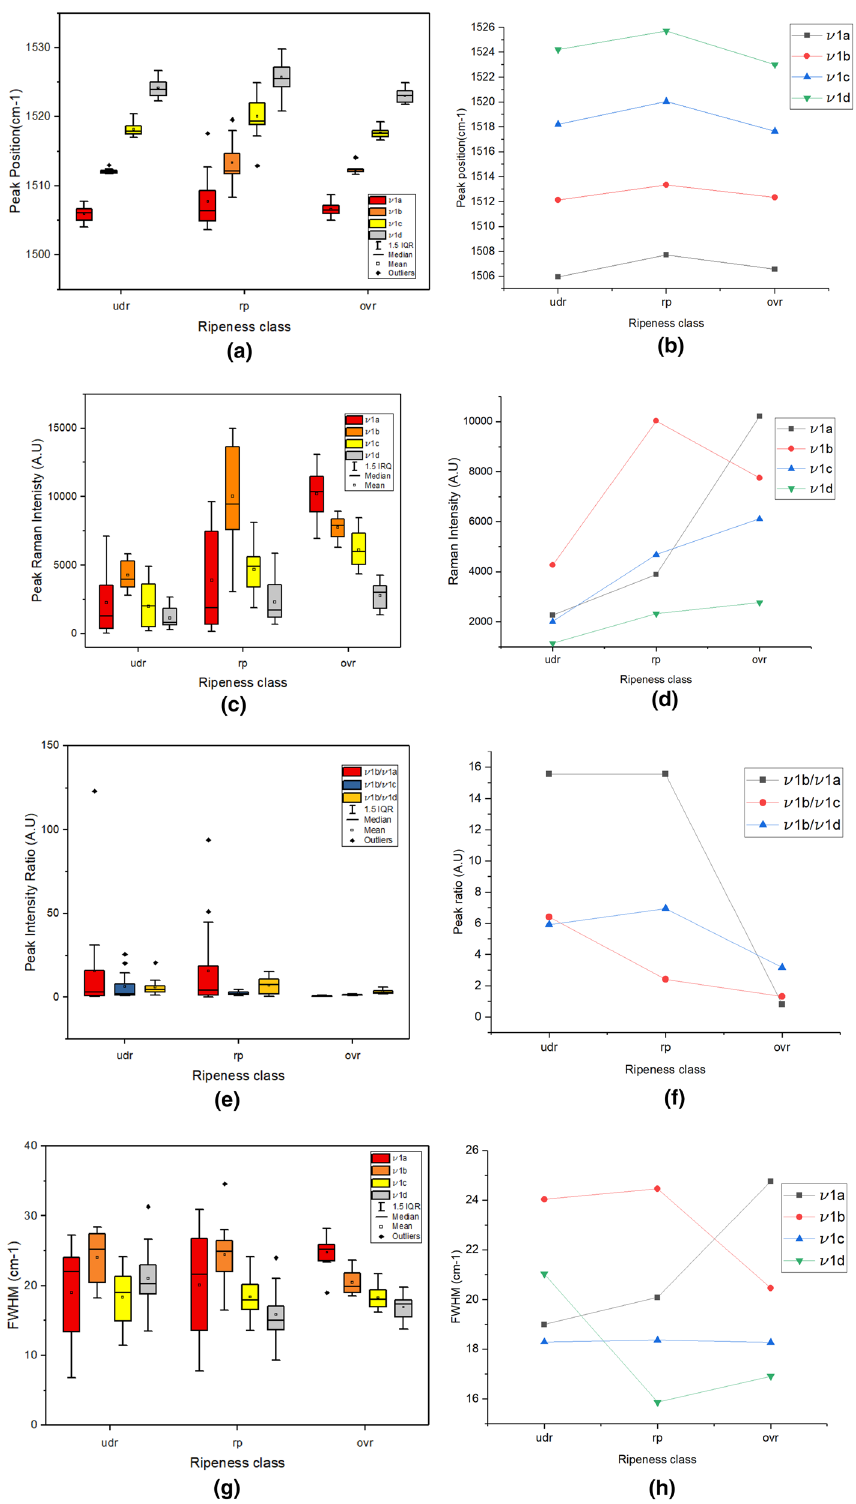
Figure 2. ( a ) Group Box plot of feature 1: Raman peak position. ( b ) Mean plot of feature 1 for 3 levels of ripeness. ( c ) Group Box plot of feature 2: Raman peak intensity. ( d ) Mean plot of feature 2 for 3 levels of ripeness. ( e ) Group Box plot of feature 3: Peak ratio. ( f ) Mean plot of feature 3 for 3 levels of ripeness. ( g ) Group Box plot of feature 4: FWHM. ( h ) Mean plot of feature 4 for 3 levels of ripeness ( udr under ripe, rp ripe, ovr over